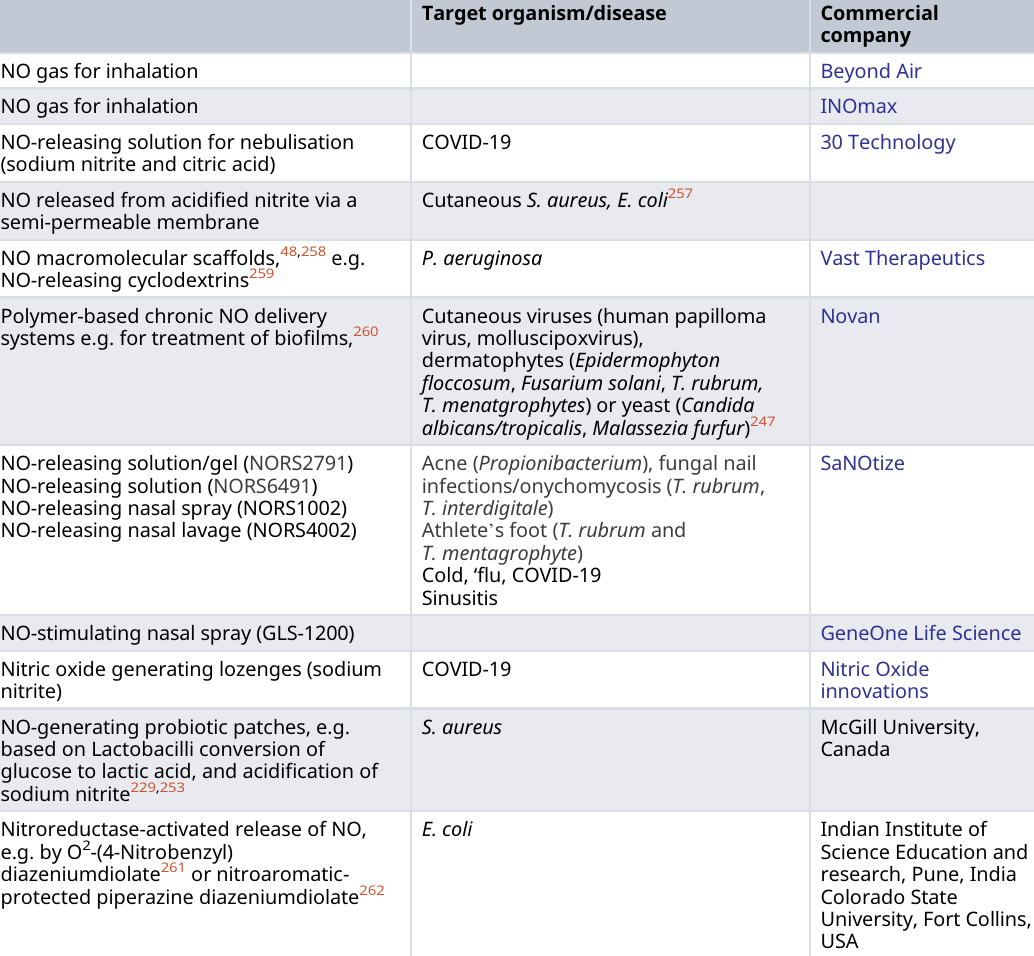
Table 8. Examples of commercial development of novel nitric oxide donors/agents with efficacy against target disease and microbes (where relevant, last searched 15 March 2021). Target